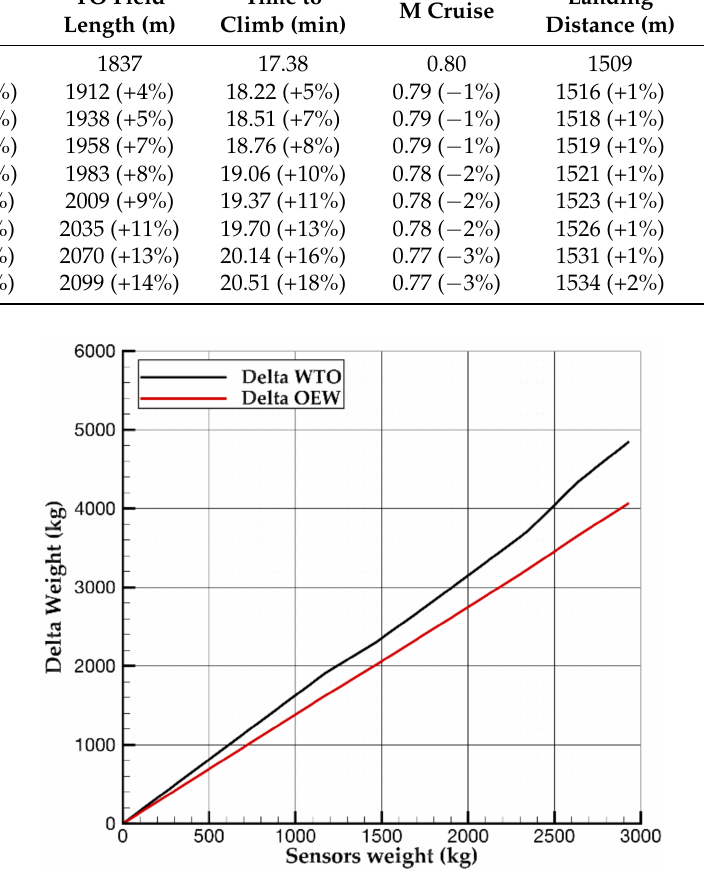
Figure 6. Effect of sensors weight on aircraft WTO and